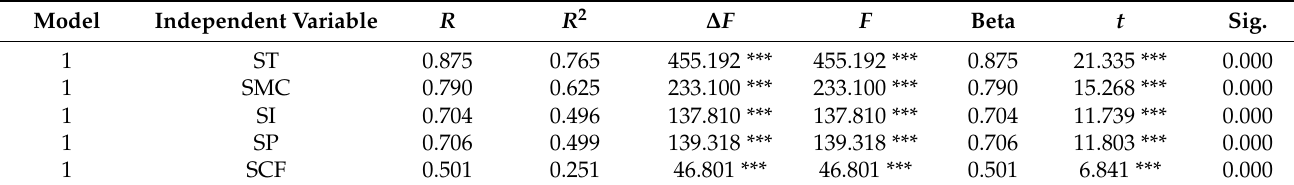
Table 1. The simple linear regression analysis coefficients of the five dimensions of